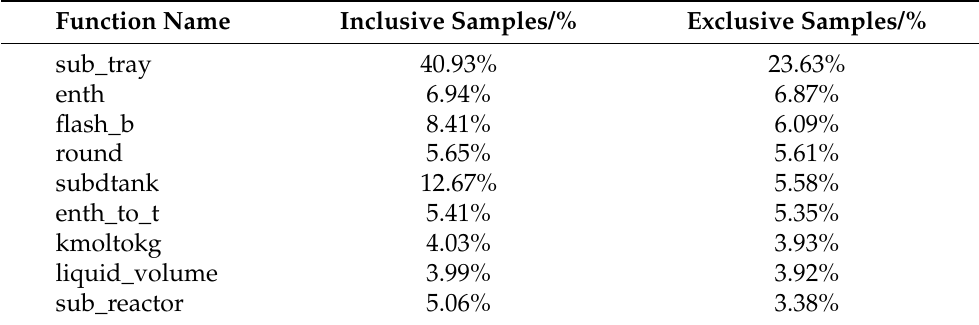
Table 1. The most time-consuming